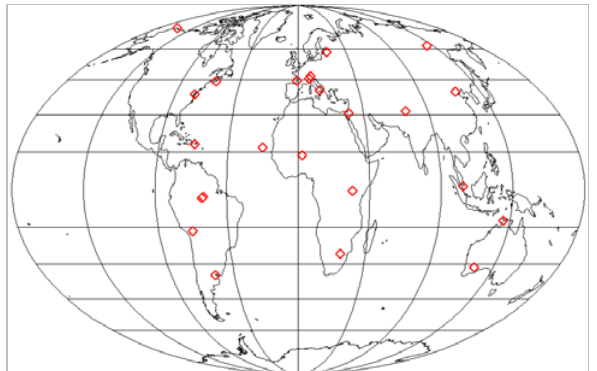
Figure 4. Geographical distribution of the selected core+back- up test sites for the L2A Validation (Red asterisks: Test sites with sunphotometers for AOT, WV and BOA validation; Green diamonds: Test sites for in-situ surface reflectance measurements; Orange squares: Test sites for SC